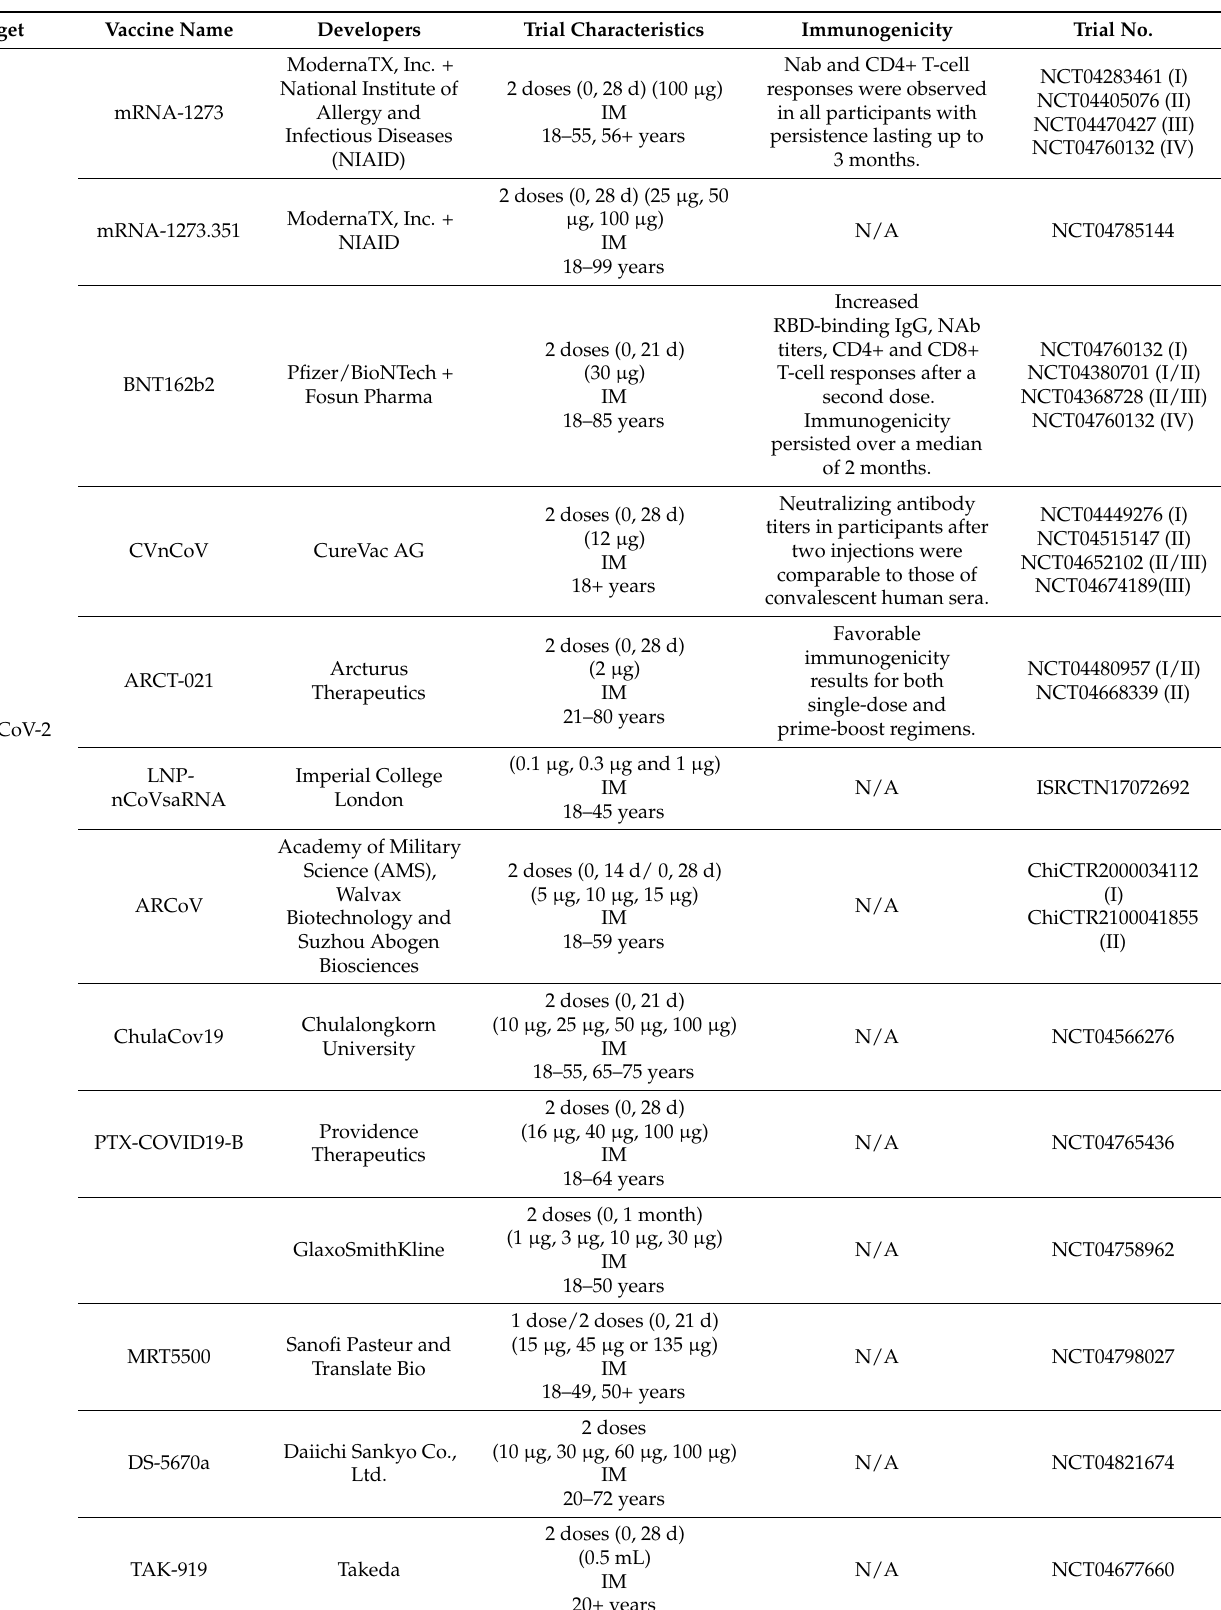
Table 3. Summary of clinical studies assessing infectious disease mRNA